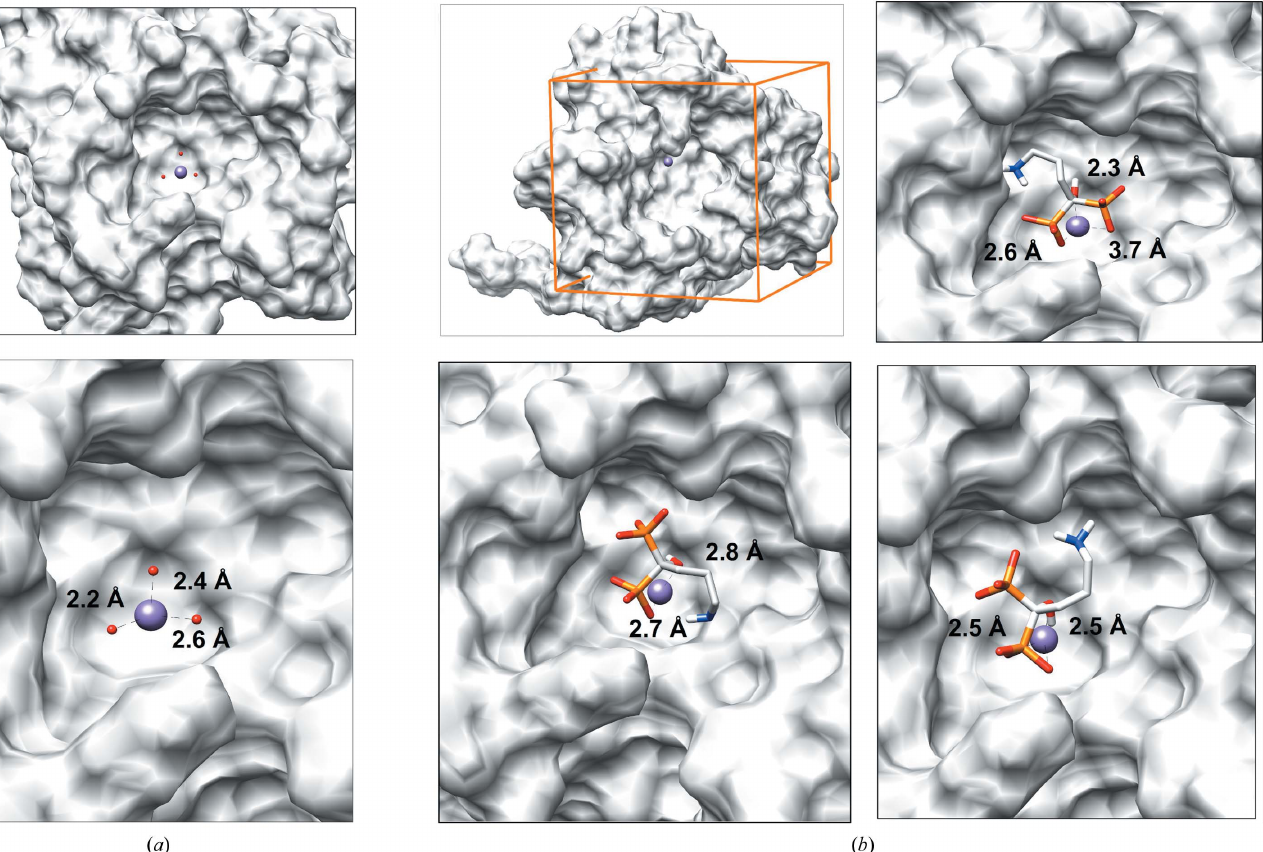
Figure 4 Exploration of potential ALD poses resulting from docking experiments using the crystal structure of MOPV NP-exo complexed with Mn 2+ . ( a ) Molecular-surface representation of the MOPV NP-exo structure complexed with Mn 2+ , which is represented as a purple sphere and coordinated by three water molecules (red spheres). The positioning of the water molecules serves as a reference for potential binding modes. Their distances from the ion are given in the enlargement (lower panel). ( b ) Molecular-surface representation of the MOPV NP-exo structure complexed with Mn 2+ depleted of water molecules. The orange box corresponds to the relaxed docking grid encompassing the active site; the ion is at its center. The three best poses compatible with the observed unrefined density (Supplementary Fig. S3) and the positions of the water molecules are shown. The given distances are compatible with the observed distances to coordinated